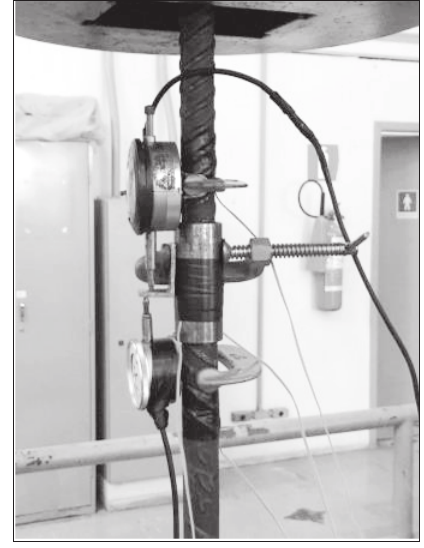
Instrumentation scheme with individual transducers used in test methods 1 and 2